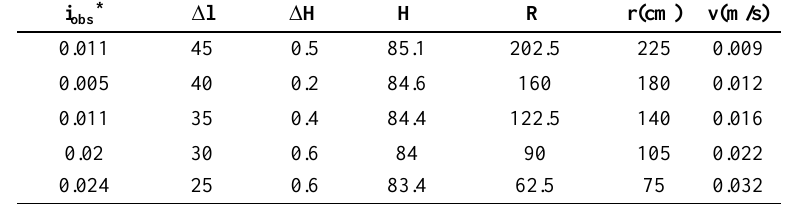
Table 4. i values measured by the Method I in the depth of 85 cm and level of 20 cm obs